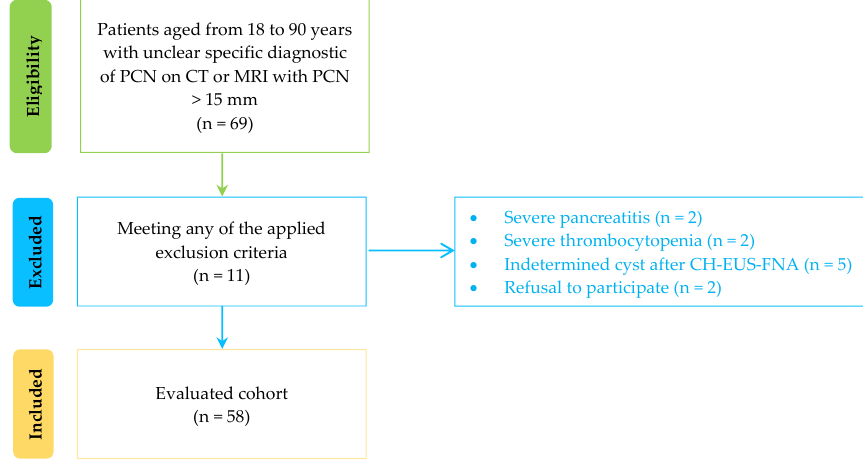
Figure 1. Study population flowchart (PCN- pancreatic cystic neoplasm; CT—computer tomography; MRI- magnetic resonance imaging; CH-EUS-FNA- contrast-enhanced guided endoscopic ultrasound fine needle aspiration).